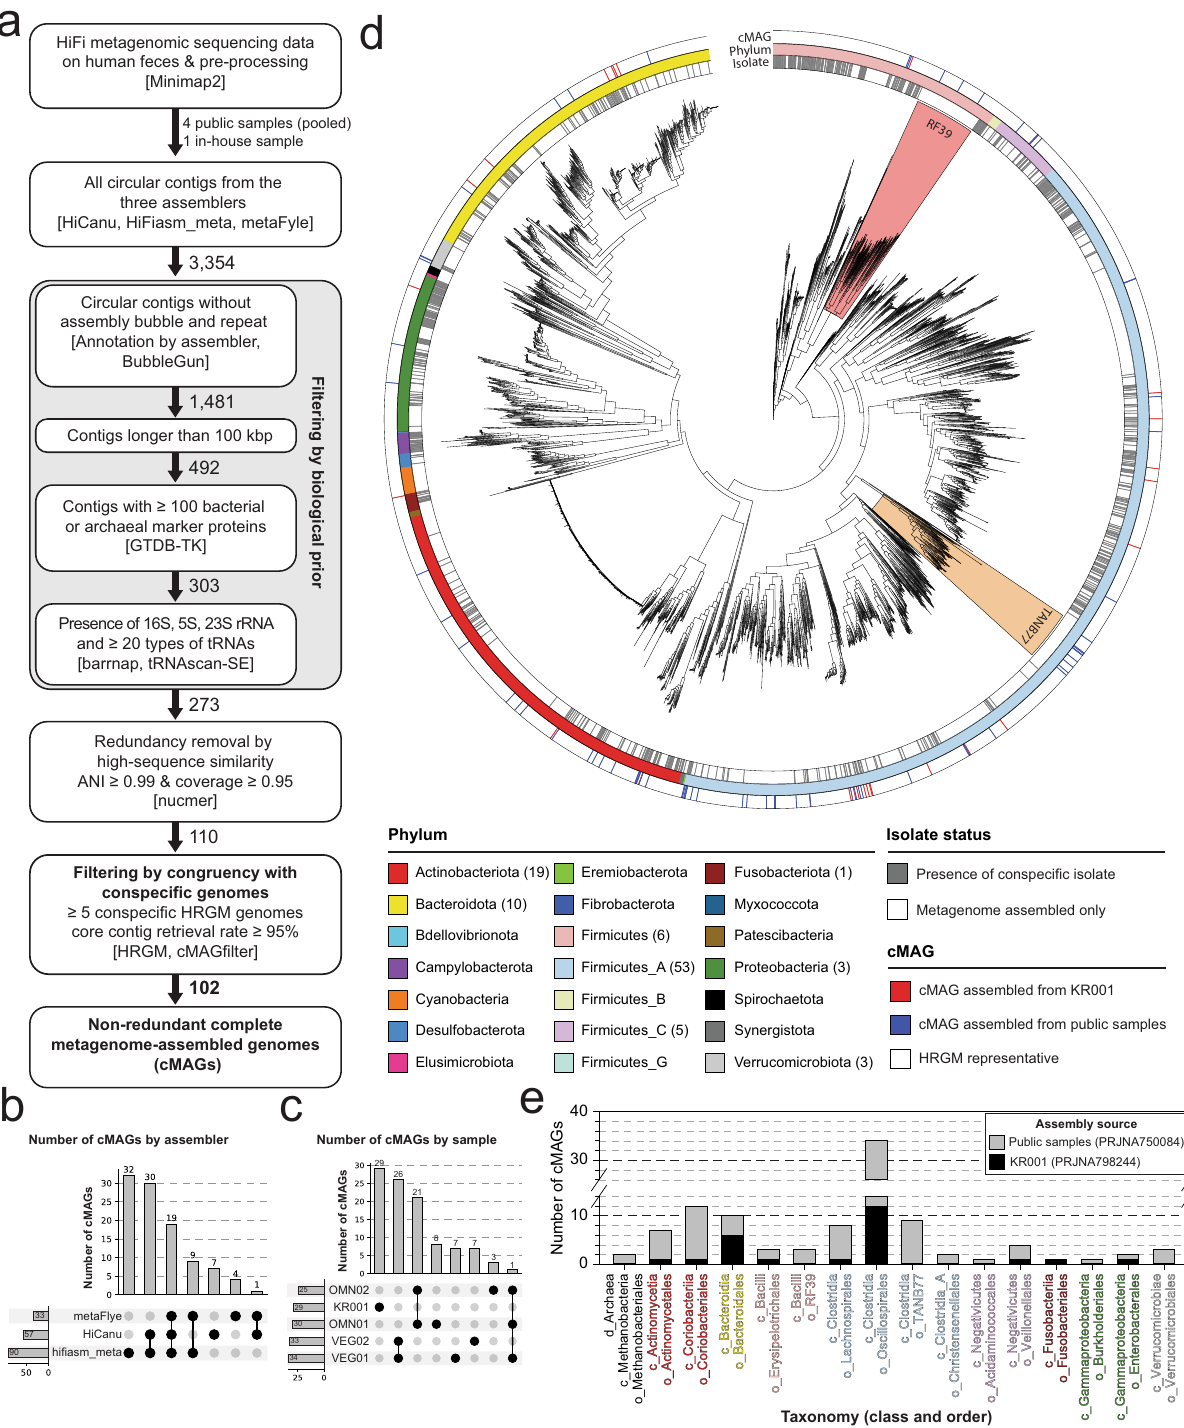
Fig. 1 | Assembly of 102 complete metagenome-assembled genomes (cMAGs) from human fecal high-accuracy long-read (HiFi) metagenomic sequencing samples. a Schematic diagram illustrating the HiFi cMAG assembly work fl ow. b Number of fi nal cMAGs assembled from each assembler. Overlapping areas represent redundant genomes assembled by more than one assembler. c Number of cMAGs assembled from each sample. OMN and VEG represent the public pooled samples derived from the omnivores and vegans, respectively, and KR001 represent the newly sequenced Korean sample. d Maximum